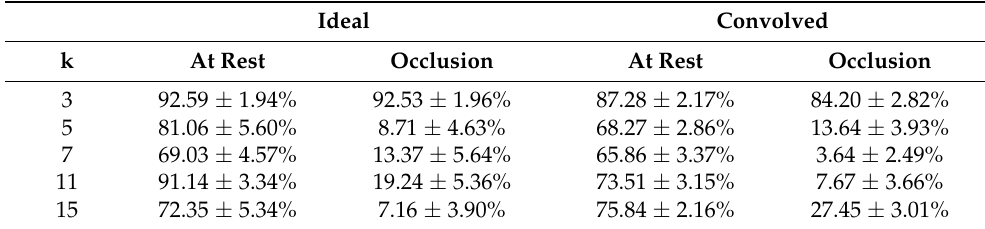
Table 4. Time-averaged and student-averaged mean and standard deviation of SO 2 estimates for the at-rest and occlusion conditions in this study (top) compared with values from recent literature